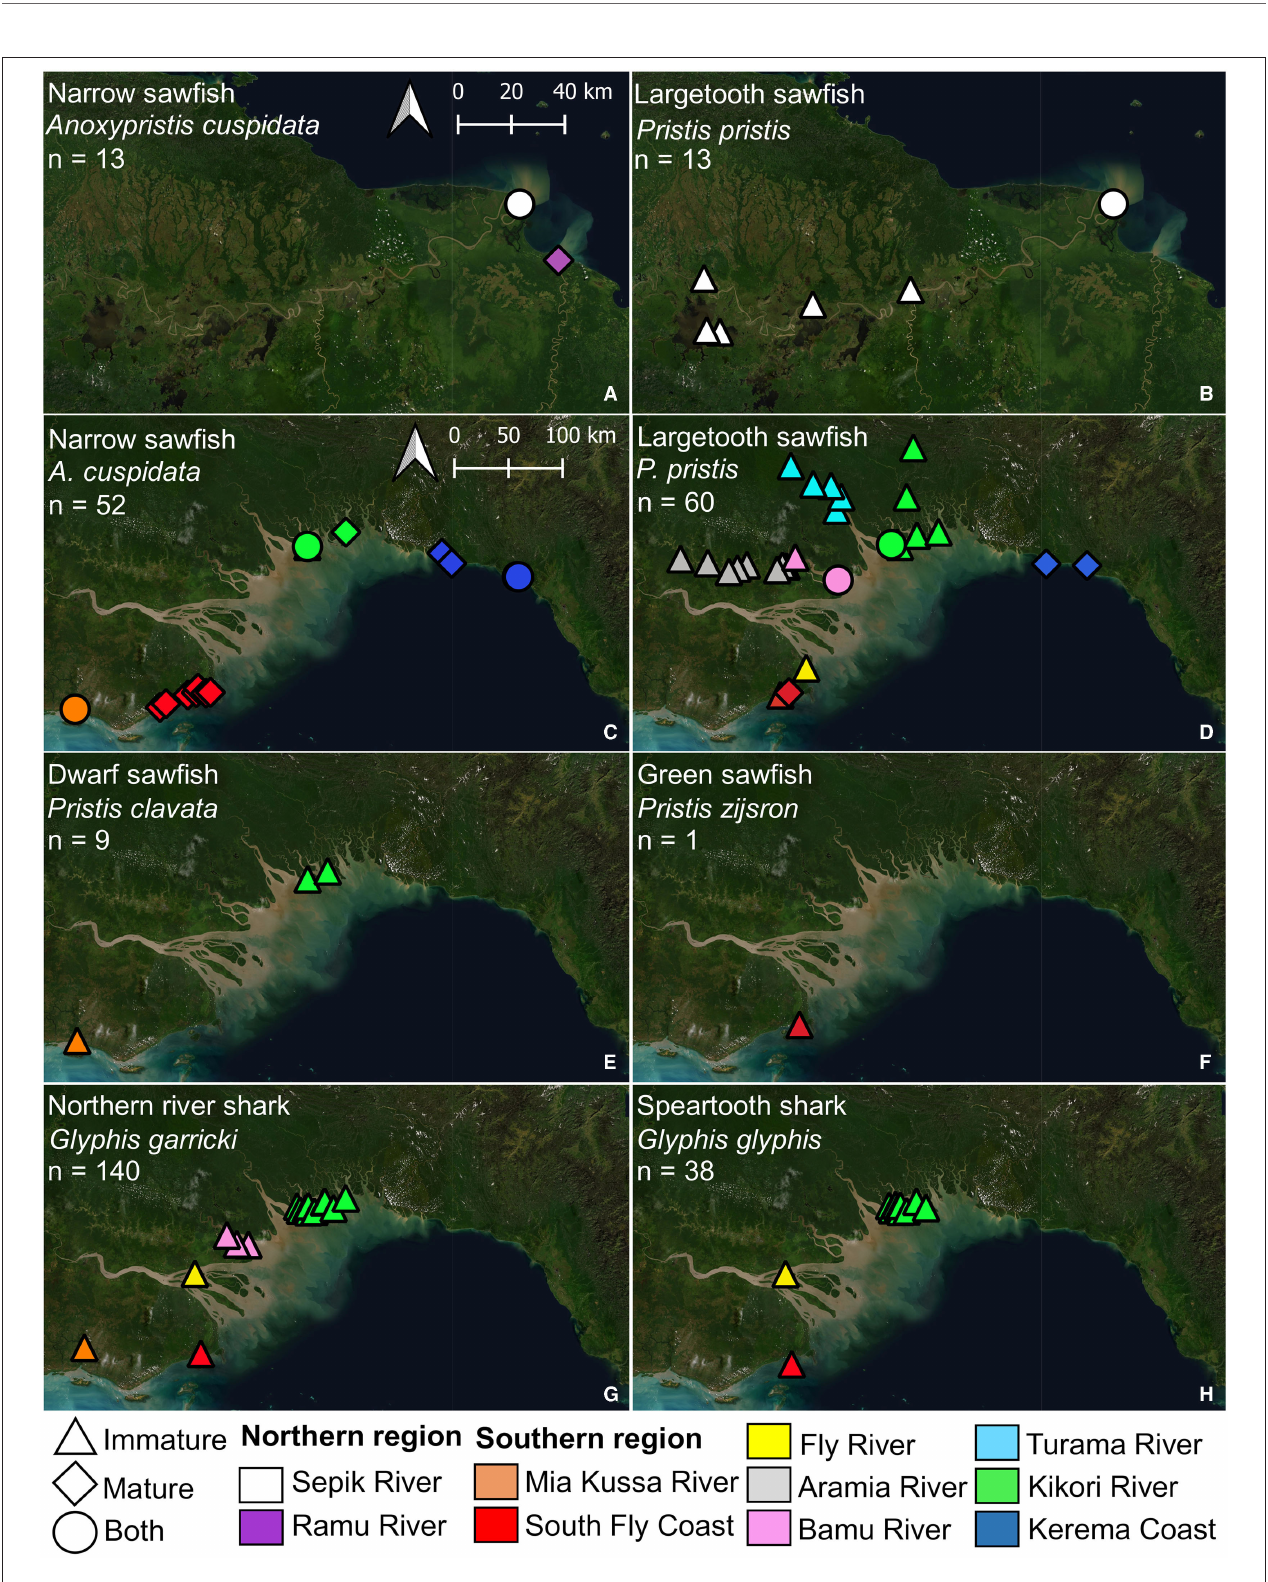
FIGURE 4 | Locations where sawfish (A–F) and river shark (G,H) species were observed during surveys of northern (A,B) and southern Papua New Guinea (C–H) . Estimated maturity of each specimen observed is indicated, and abundance ( n ) for each species is given.